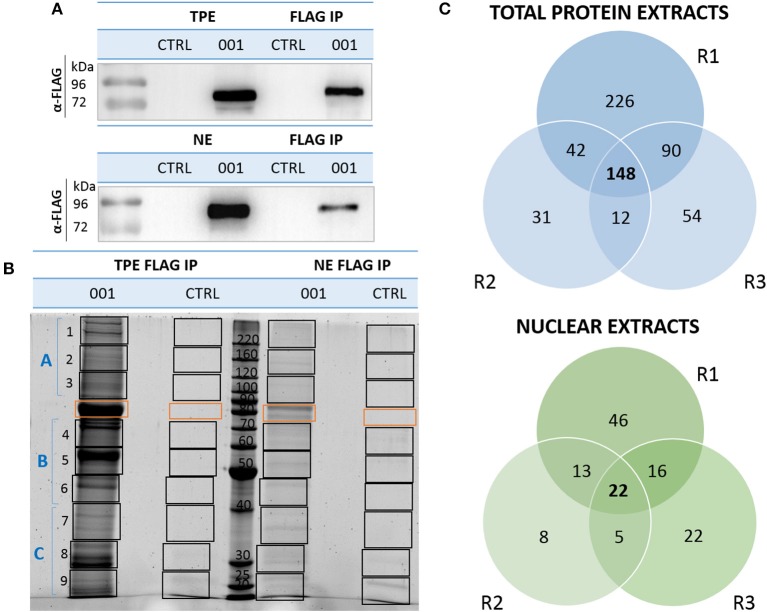
Isolation and identification of ANKRD55 interactome components by nLC-MS/MS. (A) Recombinant ANKRD55 isoform (001) was detected in nuclear extracts (NE), total protein extracts (TPE) and eluted fractions (FLAG IP) with FLAG Ab by WB. As negative control, cells were cultivated under the same conditions, but without transfection agent (CTRL). (B) A SYPRO Ruby-stained SDS-PAGE showing analysis strategy of ANKRD55 complexes IP with FLAG resin from NE and TPE of HEK293 cells expressing isoform 001. ANKRD55 band or corresponding position (CTLR) is indicated with orange rectangle, while black rectangles show contiguous gel slabs processed for mass spec. WB and SDS-PAGE are representative of three independent biological replicates. (C) Venn diagram shows numbers of unique and shared interactors in each independent replicate (R1, R2, and R3) out of three performed for ANKRD55 IP from TPE and NE.